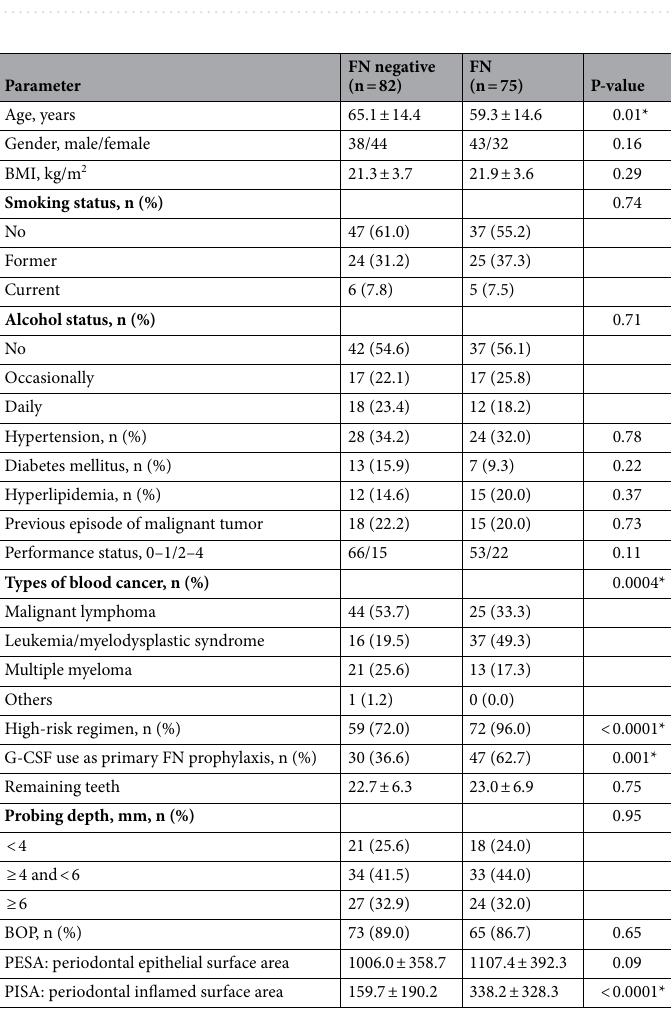
Figure 1. Flowchart showing patient selection.